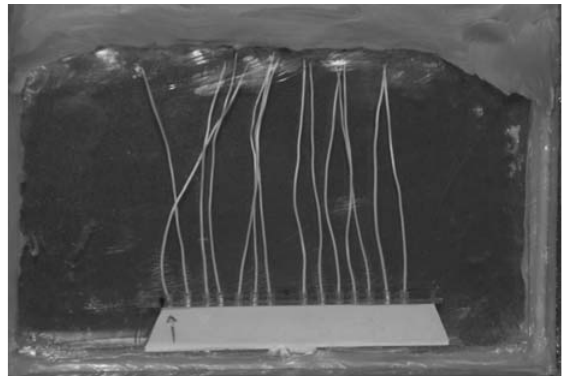
Figura 3. Caixa de vidro com os segmentos de raízes imersas em solução de solo com pH = 6,2 e com 80 mg L -1 de Fe. A caixa foi selada com massa de modelar e mantida em ambiente de N